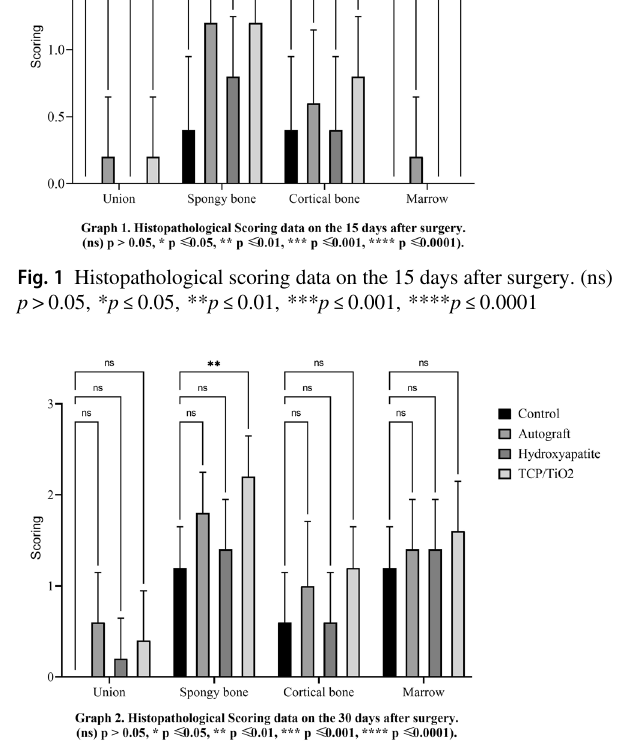
Fig. 2 Histopathological scoring data on the 30 days after surgery. (ns) p > 0.05, * p ≤ 0.05, ** p ≤ 0.01, *** p ≤ 0.001, **** p ≤ 0.0001